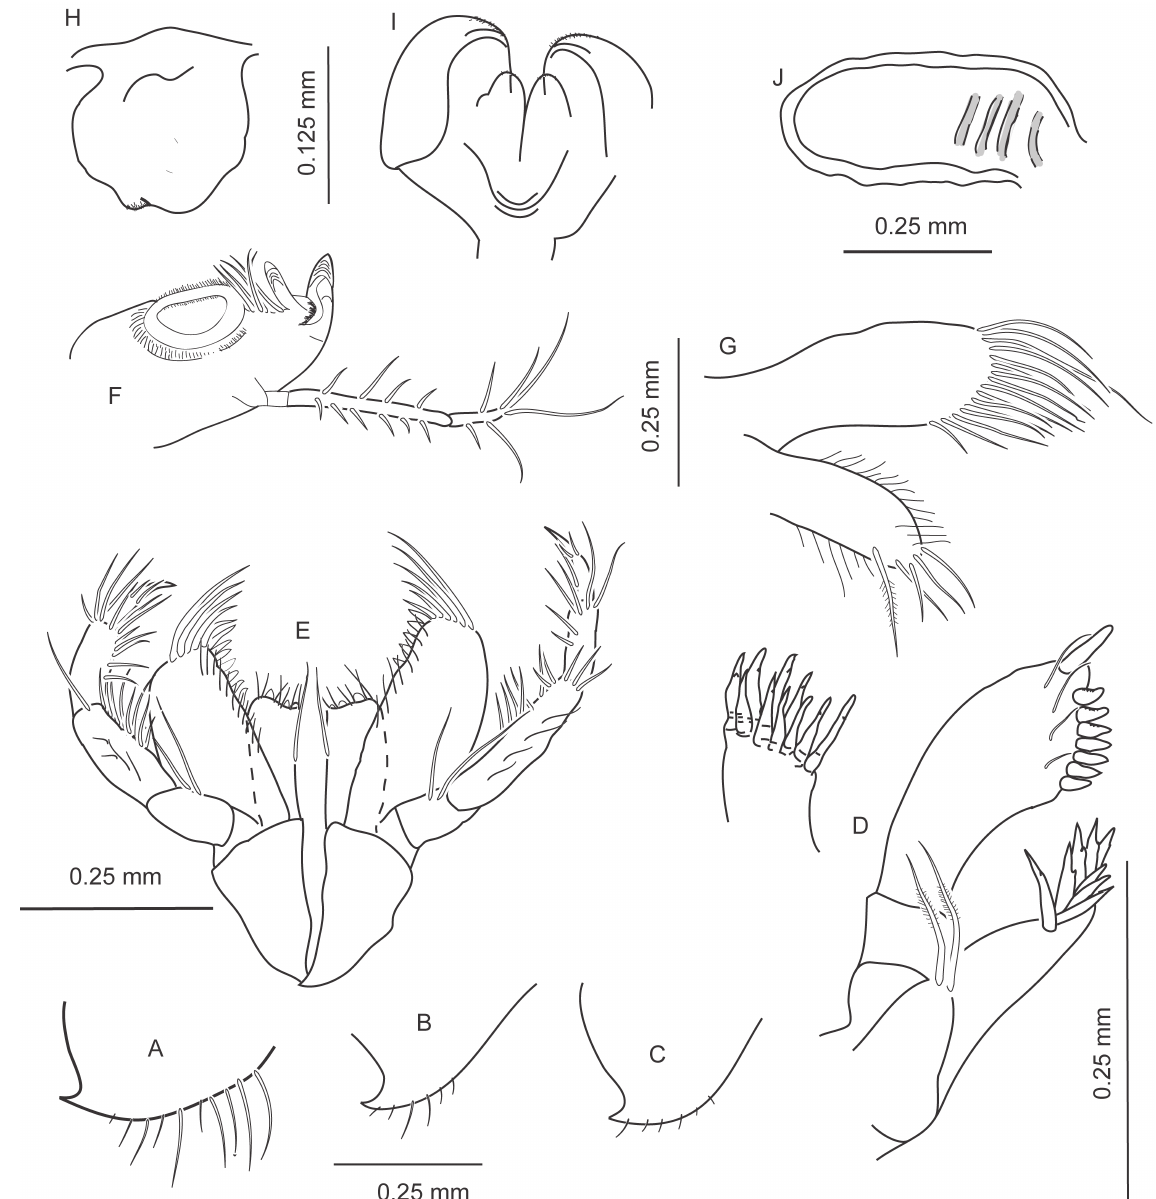
Fig. 14. Lepechinella victoriae sp. nov., holotype, ♀. A . Right Ep1. B . Right Ep3. C . Right Ep2. D . Right and left Mx1. E . Left and right Mxp. F . Right mandible. G . Left Mx2. H . Upper lip. I . Lower lip. J . Gill of